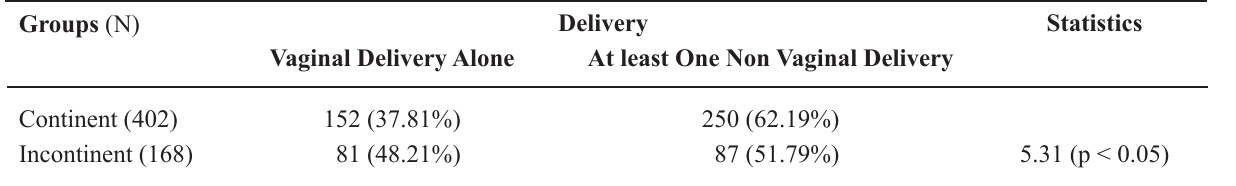
Table 2 – Influence of delivery as a determinant factor of urinary